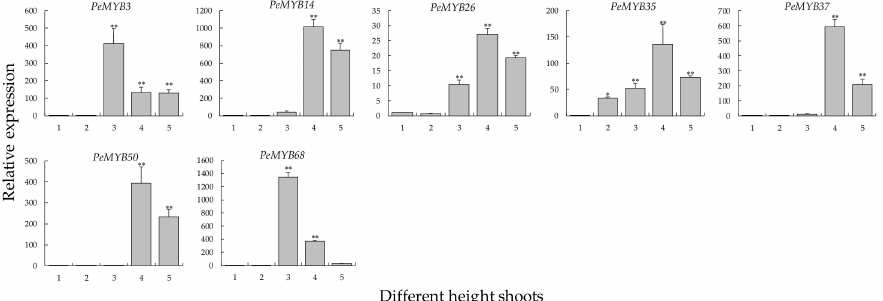
Figure 9. Expression analysis of 7 PeMYB s in di ff erent height shoots using qRT-PCR. PeNTB was used as the reference gene. Average and error bars represented standard deviation of three biological replicates. Asterisks indicated significant di ff erence compared to the transcription level of control groups (* p < 0.05, and ** p < 0.01). 1: 1.0 m shoots; 2: 2.0 m shoots; 3: 4.0 m shoots; 4: 6.0 m shoots; and 5: 8.0 m